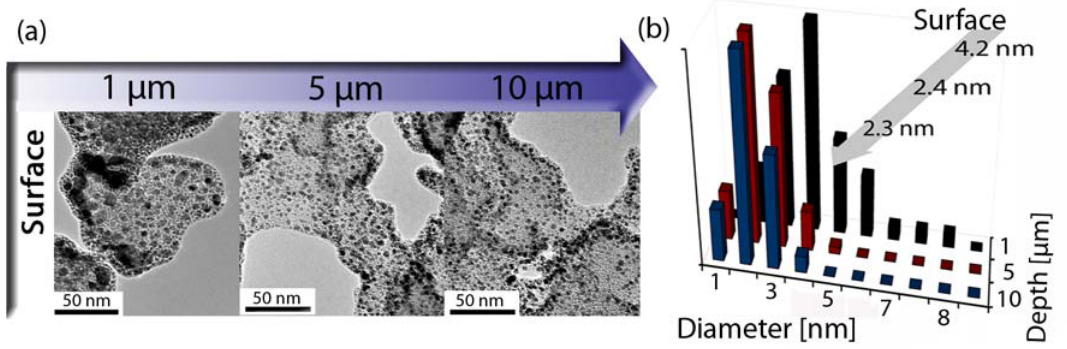
Figure 12. Morphology of a Pt loaded CA (10 ALD cycles). (a) Cross-sectional TEM micrographs revealing the high dispersion of Pt. The images were taken at different depths below the outer surface. (b) Corresponding particle size histogram and averaged particle diameters [107].